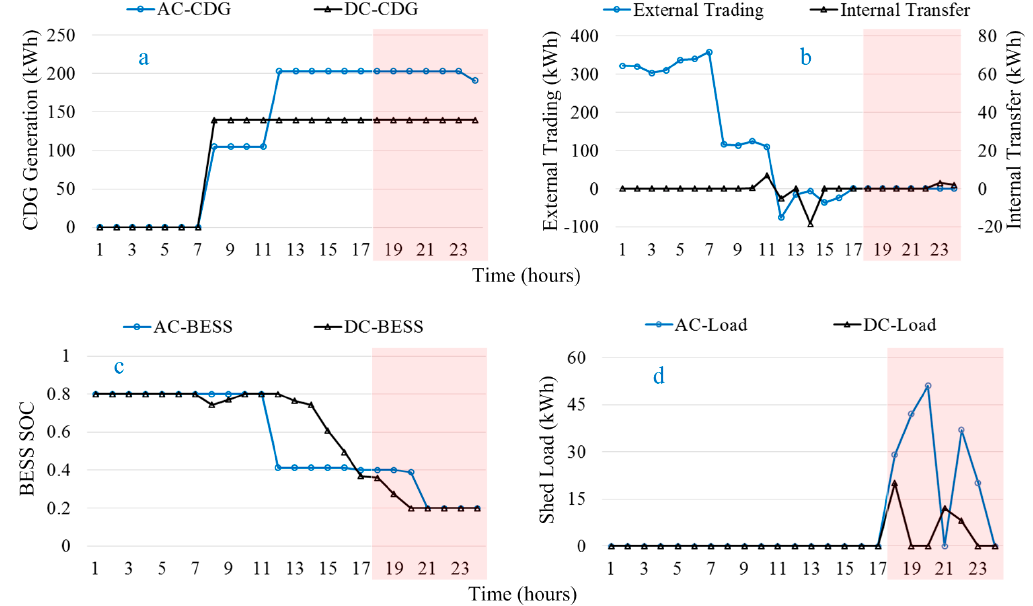
Figure 14. Operation results of conventional case: ( a ) CDG generation; ( b ) power trading; ( c ) BESS SOC; ( d ) load shedding.